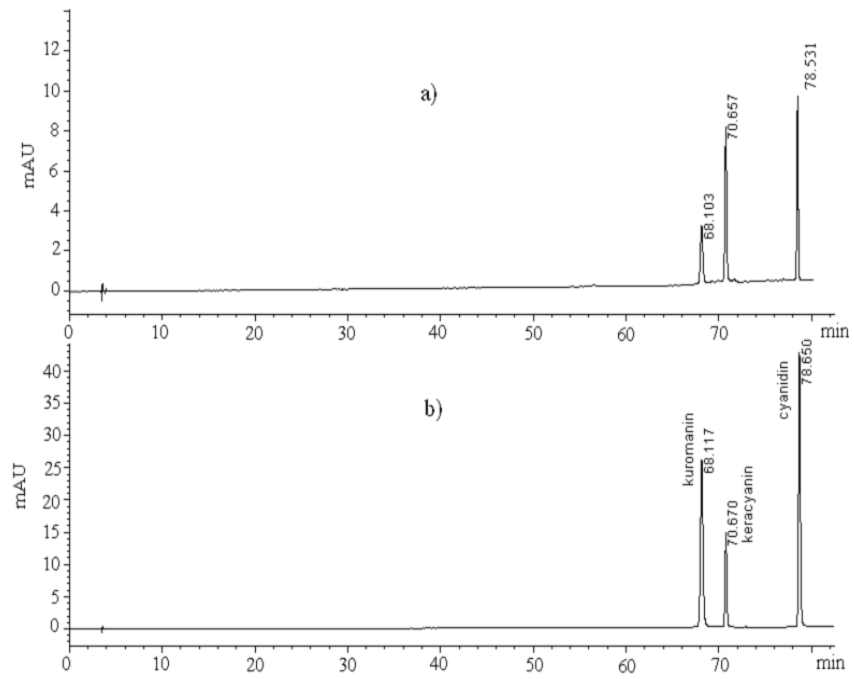
Figure 2. HPLC-DAD signals of ( a ) a crude methanolic extract from P. latifolia L. fruits for identification of its anthocyanin components, and ( b ) a standard anthocyanin mixture containing keracyanin, kuromanin and cyanidin obtained at 520